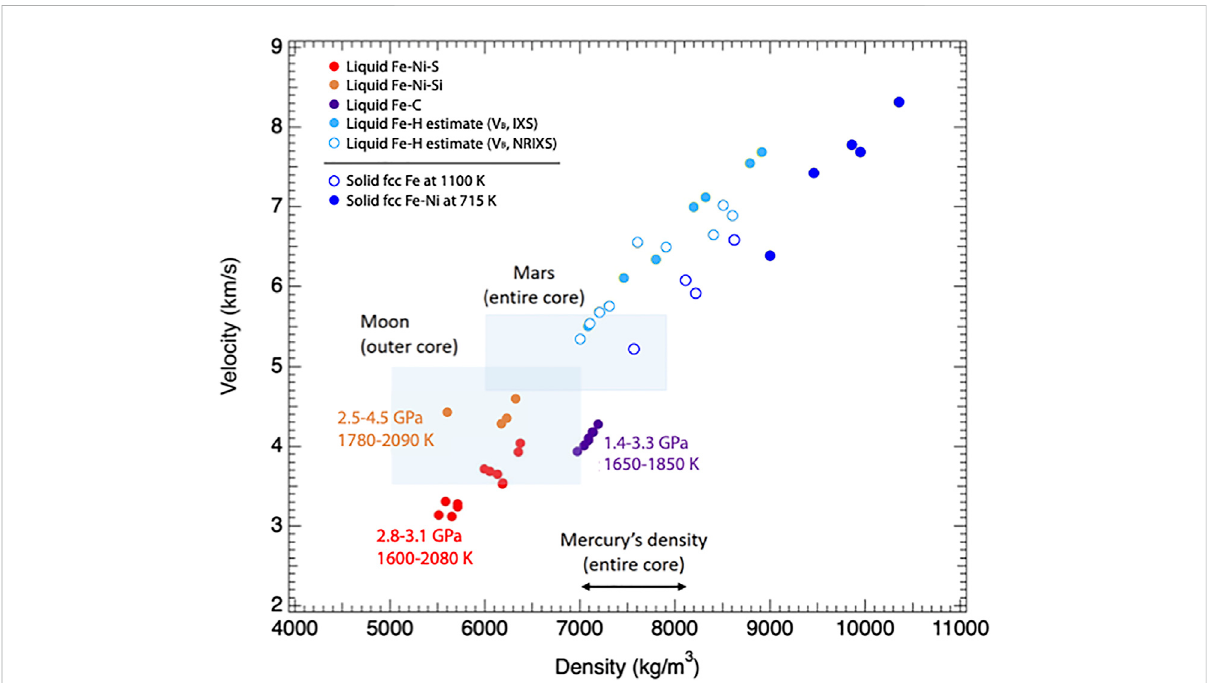
FIGURE 5 Compressional velocity-density relationship of liquid iron alloys from experiments, and comparison with solid fcc iron. Both properties were measured as part of the same studies. Data for Fe-H are from studies on solids (not liquids) at room temperature by Mao et al. (2004) (orange) and Shibazakietal.(2012)(yellow),andthebulksoundvelocity(V B )datawereplottedhere(seetextfordetails).DataforliquidFe-Ni-SandliquidFe-Ni-Si are from Terasaki et al. (2019), and data for liquid Fe-C are from Shimoyama et al. (2016). The velocity-density relations for solid fcc-Fe (Antonangeli et al., 2015) and fcc-FeNi alloy (Kantor et al., 2007) are shown for comparison (in light and dark blue). The entire dataset covers